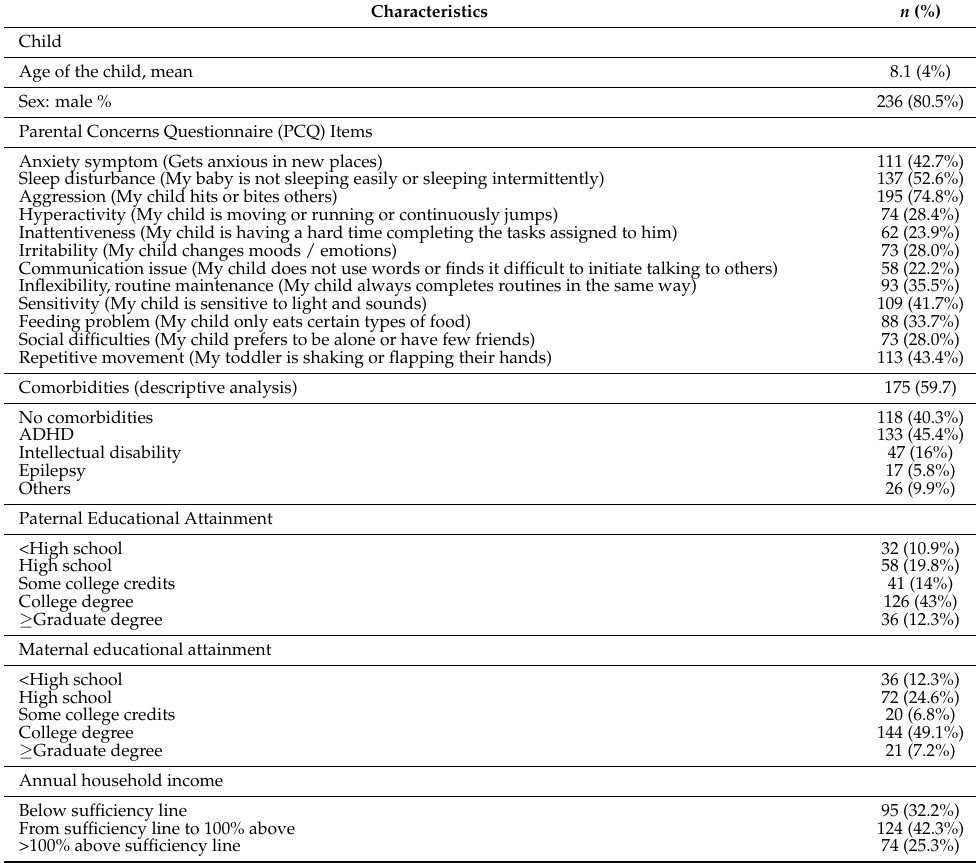
Table 1. Demographic, health condition, and comorbidities of children based on parents’